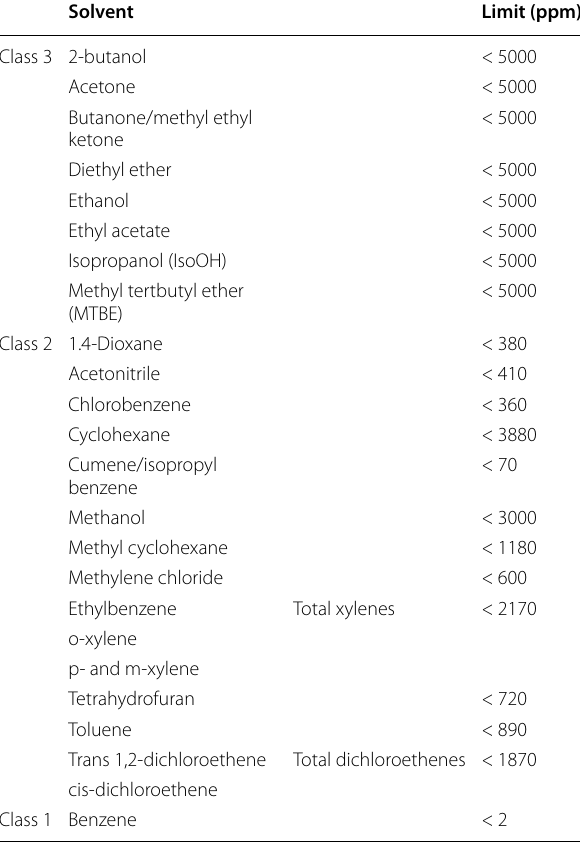
Table 1 Residual solvent limits imposed by ICH and USP (International Community of Harmonization (ICH), 2011; United States Pharmacopeia (USP),